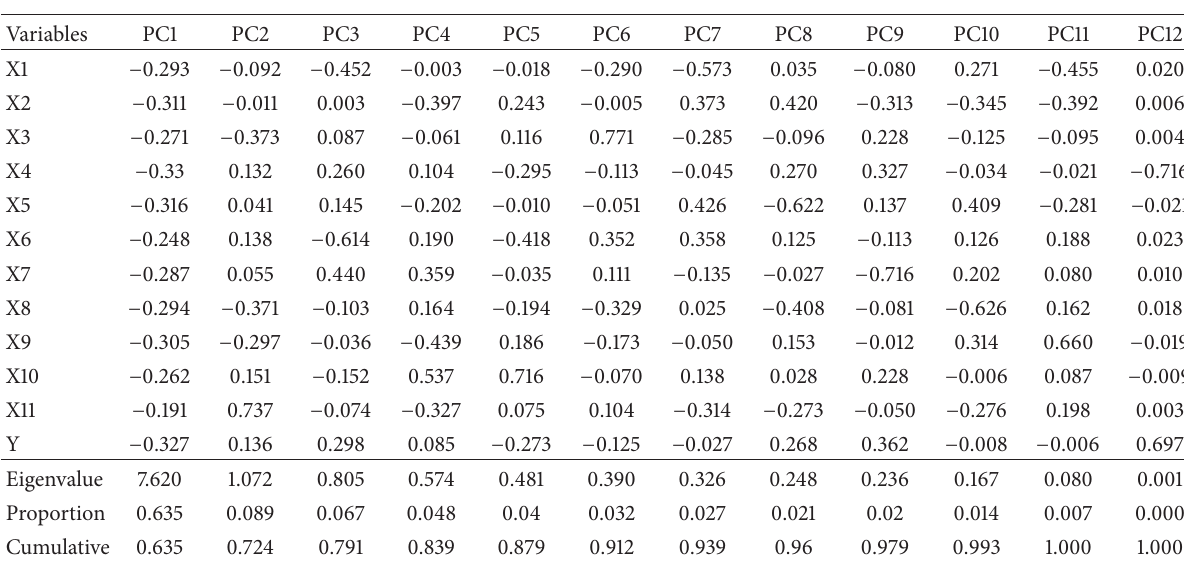
Table 10: (a) Eigenvalues and the correlation matrix for the estimated variables of wheat using principal component procedure for inoculated wheat cultivars under different water levels. (b) Eigenvalues and the correlation matrix for the estimated variables of wheat using principal component procedure for noninoculated wheat cultivars under different water